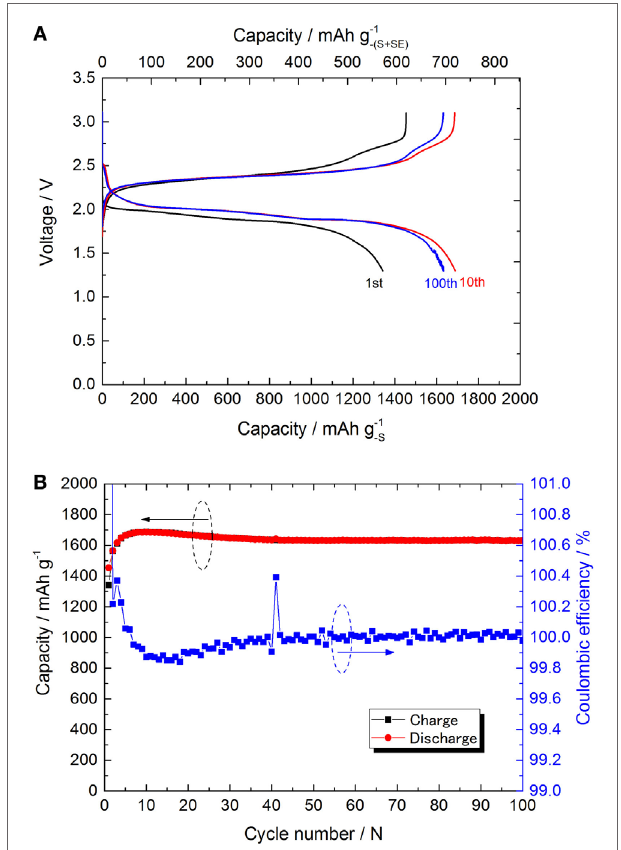
FigUre 7 | (a) Charge/discharge curves of E-cell for 1st, 10th, and 50th cycle at 25°C. All the charge/discharge was operated by the same condition of S-cell. (B) Charge/discharge capacities and the coulombic efficiency are plotted versus the